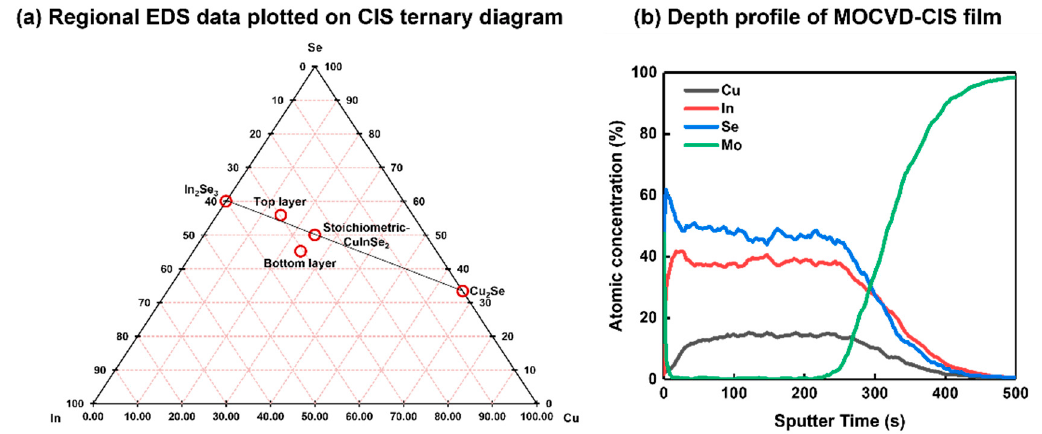
Figure 4. Comparative constituent analysis of the top and bottom layers using ( a ) EDS and ( b ) SIMS. Figure 3. Morphology of MOCVD-prepared CIS layer: ( a ) SEM top-view image; ( b ) SEM cross-sectional image.